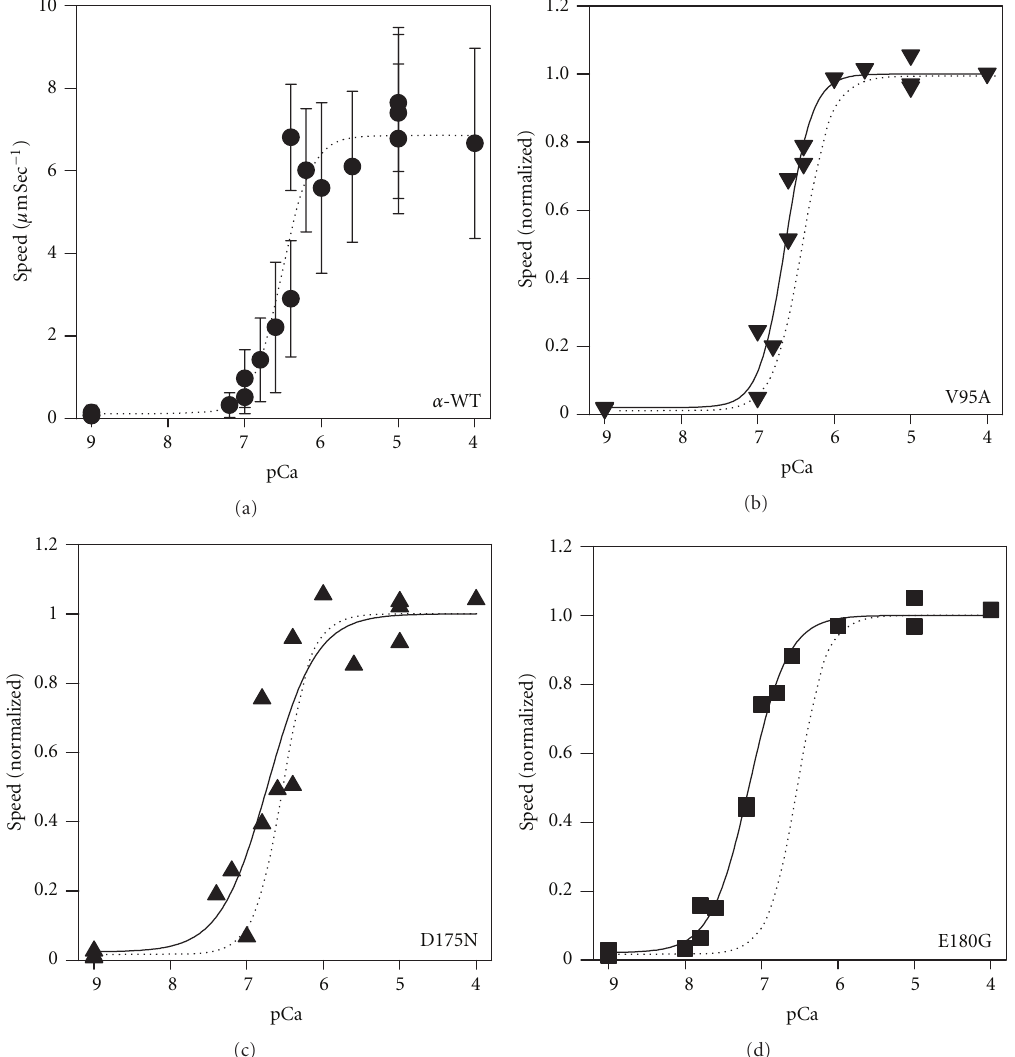
Figure 3: Ca 2+ -dependence of in vitro motility speed for regulated thin filaments reconstituted with HcTn and either, (a) α -GS-Tm WT ( • ), (b) α -GS-Tm V95A ( (cid:2) ), (c) α -GS-Tm D175N ( (cid:3) ), or (d) α -GS-Tm E180G ( (cid:4) ). In (b–d), data and regressions for each Tm were normalized to s max + s min from regression (4) for the same Tm. Each point represents the mean for one flow cell; error bars in (b–d) are comparable to those in (a). Solid lines are nonlinear least squares regression fits of the mutant Tm data to (4), and parameter estimates are given in Table 1. For comparison, the regression line for α -GS-Tm WT (a) was normalized as described above and plotted in panels (b–d) as a dotted line for